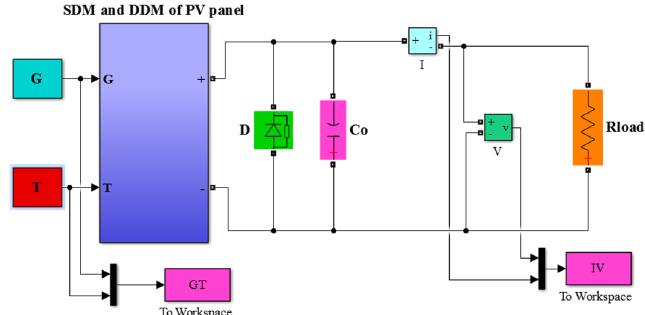
Figure 4. Simulink/Matlab block diagram of the NST-120 PV panel.